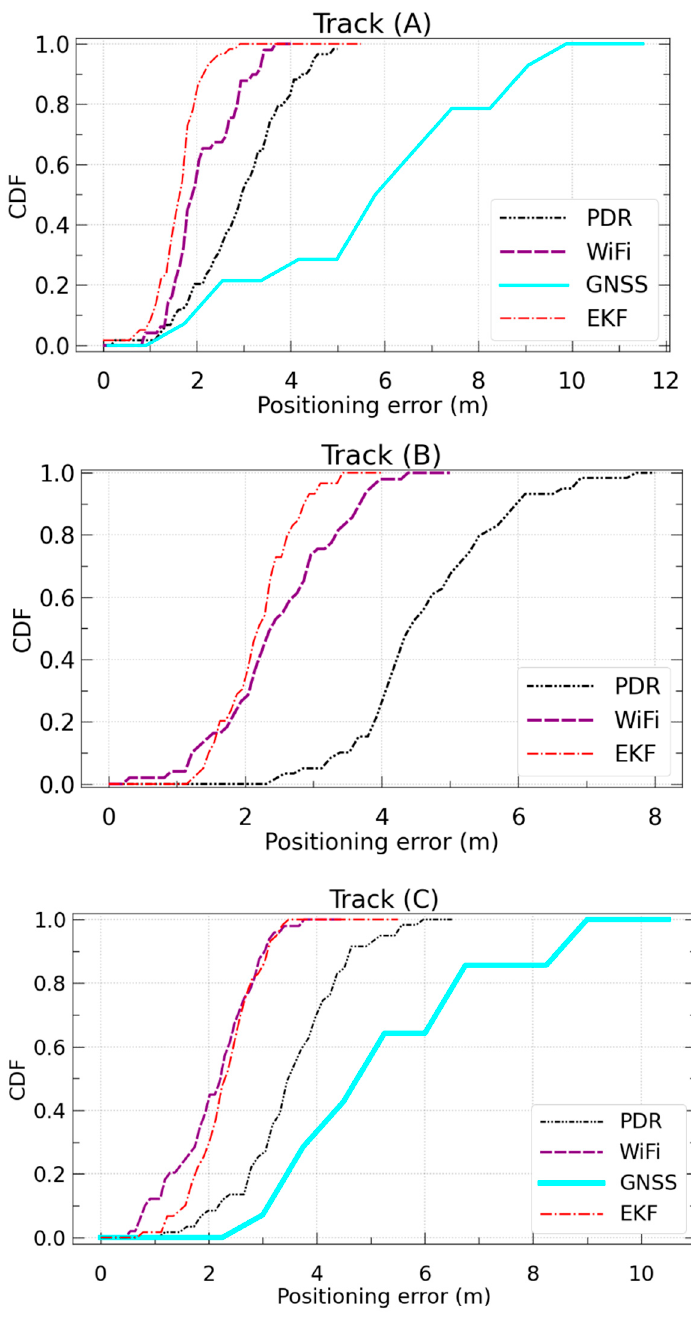
Figure 12. The CDF of the error in positioning for PDR, WiFi fingerprinting, GNSS, and EKF for tracks ( A – C ). Table 4. Positioning accuracies of the PDR, fingerprinting, GNSS, and EKF solutions.